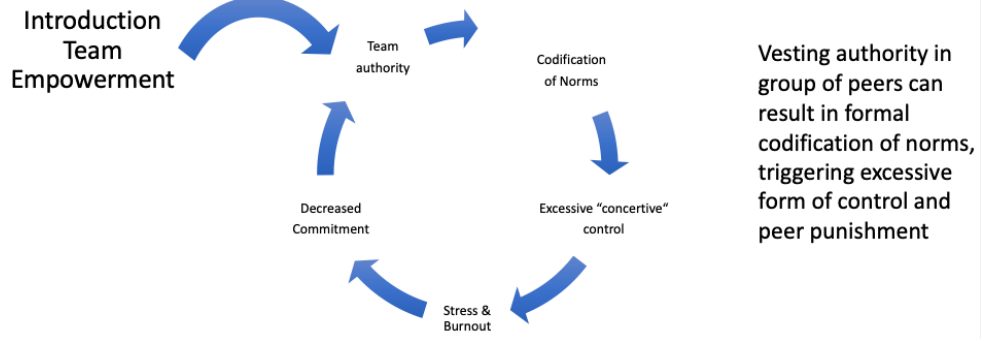
Figure 3: Example for an Empowerment